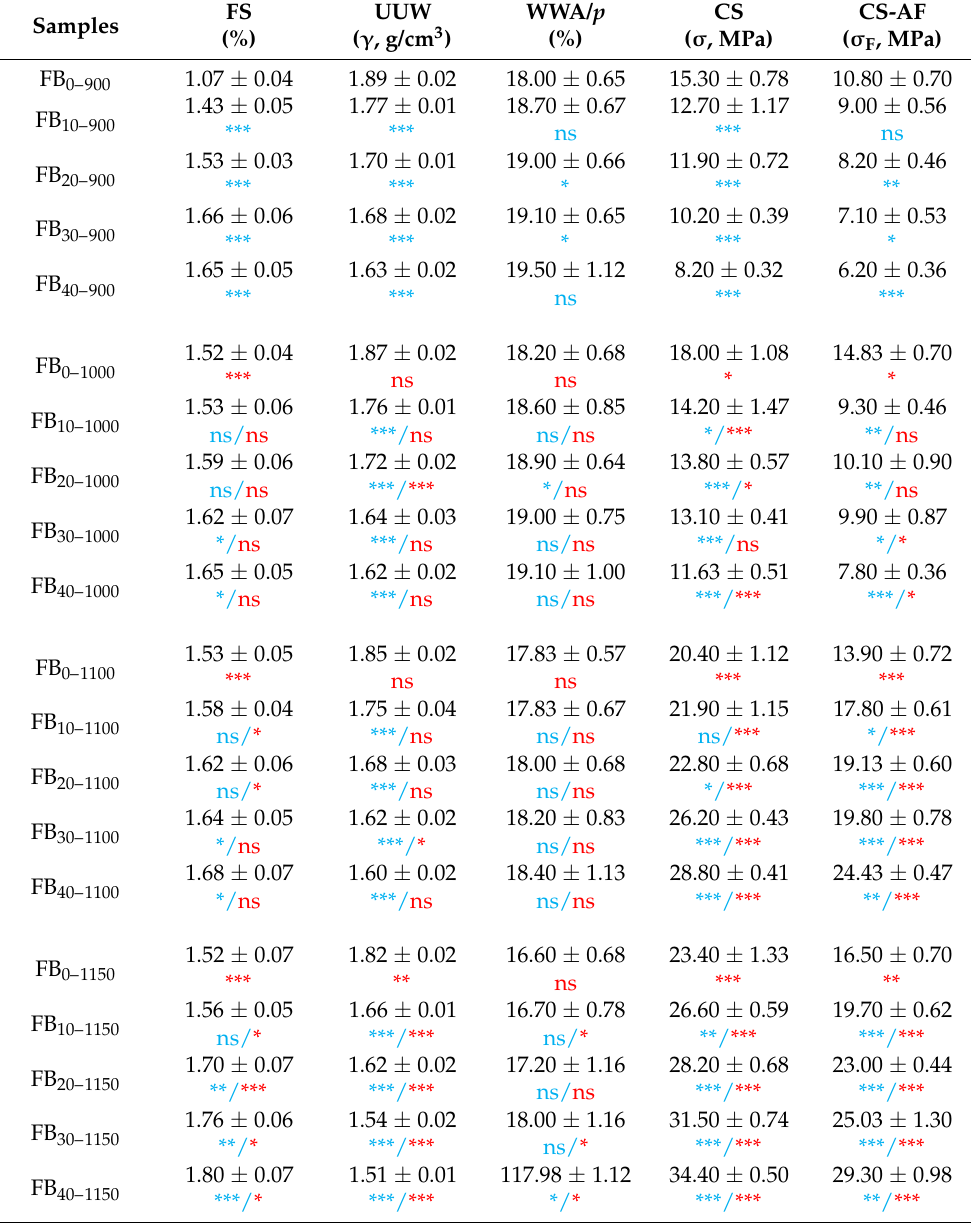
Table 2. Physical and mechanical properties of the fired brick samples produced from BA GFCNF and C NKR mixture. Subscripts in the sample descriptions indicate BA GFCNF volume fraction (0– 40%) and firing temperature (900–1150 ◦ C), respectively. FS, firing shrinkage; UW, unit weight; WA, water absorption; p , porosity; CS, compressive strength; CS-AF, compressive strength after freezing. The results are the means of three measurements; data are presented as mean ± standard error; blue asterisks represent significant differences from FB0 within each set of samples produced from C NKR and BA GFCNF mixtures at the different ratios and fired at the same temperature; red asterisks represent significant differences from FB900 within each set of samples produced from C NKR and BA GFCNF mixture at the same ratio and fired at different temperatures; the significance was determined by Student’s t test (*, p < 0.05; **, p < 0.01; ***, p < 0.005); ns, not significant).